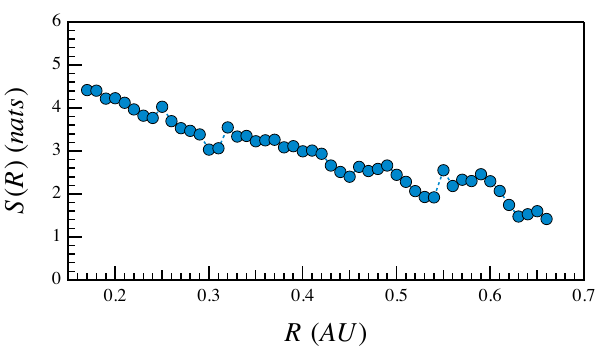
Figure 5. Behavior of the Shannon entropy S ( R ) of the filtered normal component of the magnetic field as a function of the radial distance R from the